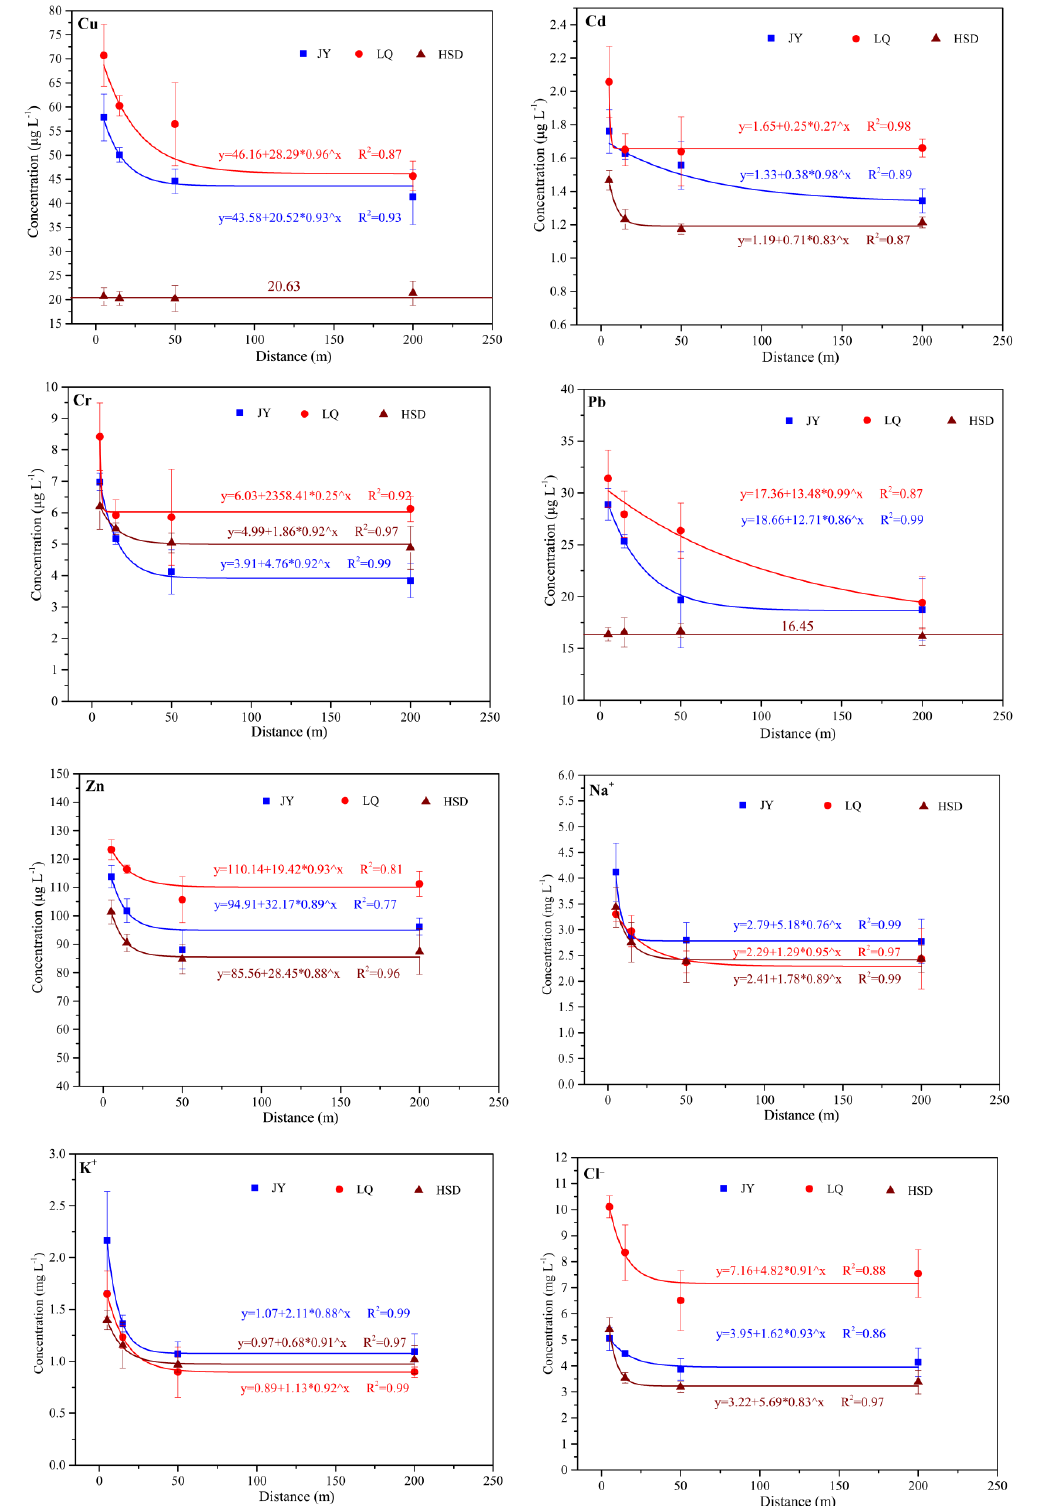
Figure 3. Regression curves of highway-related pollutants concentrations in groundwater in turfy swamp.